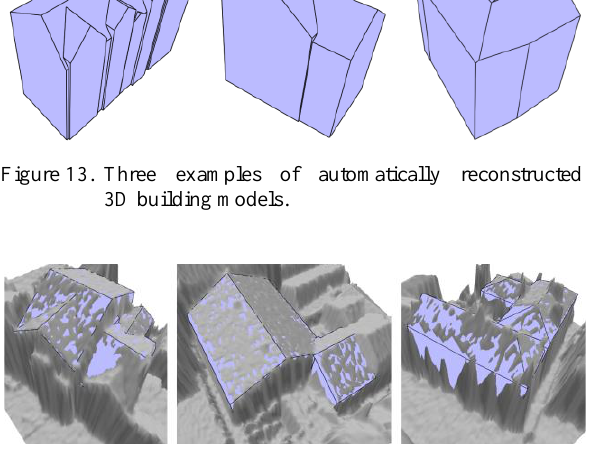
Figure 14. Three examples of automatically reconstructed 3D building models overlaid with digital surface